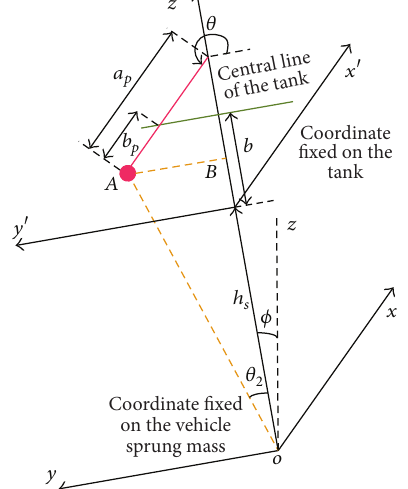
Figure 4: Top view of vehicle dynamic analysis.